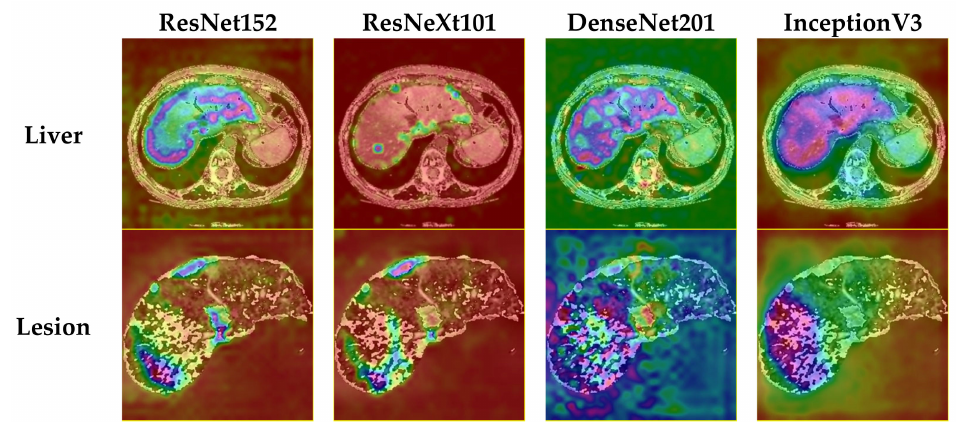
Figure 13. Feature extractor activations for each individual model.